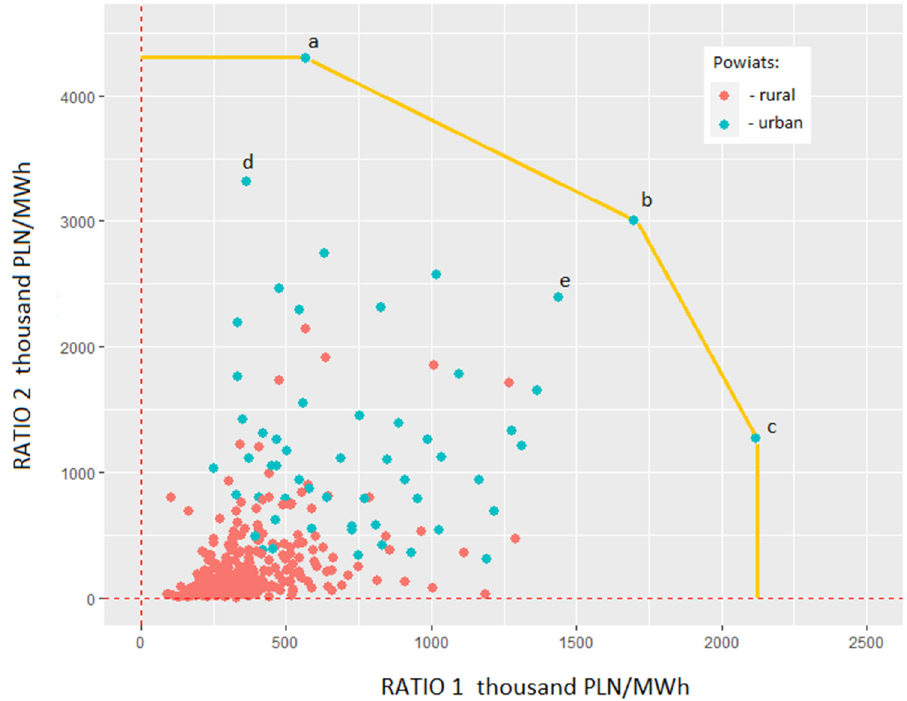
Figure 6. Relative efficiency of the powiats for the period 2014–2020 for the total operators, excluding the energy sector.